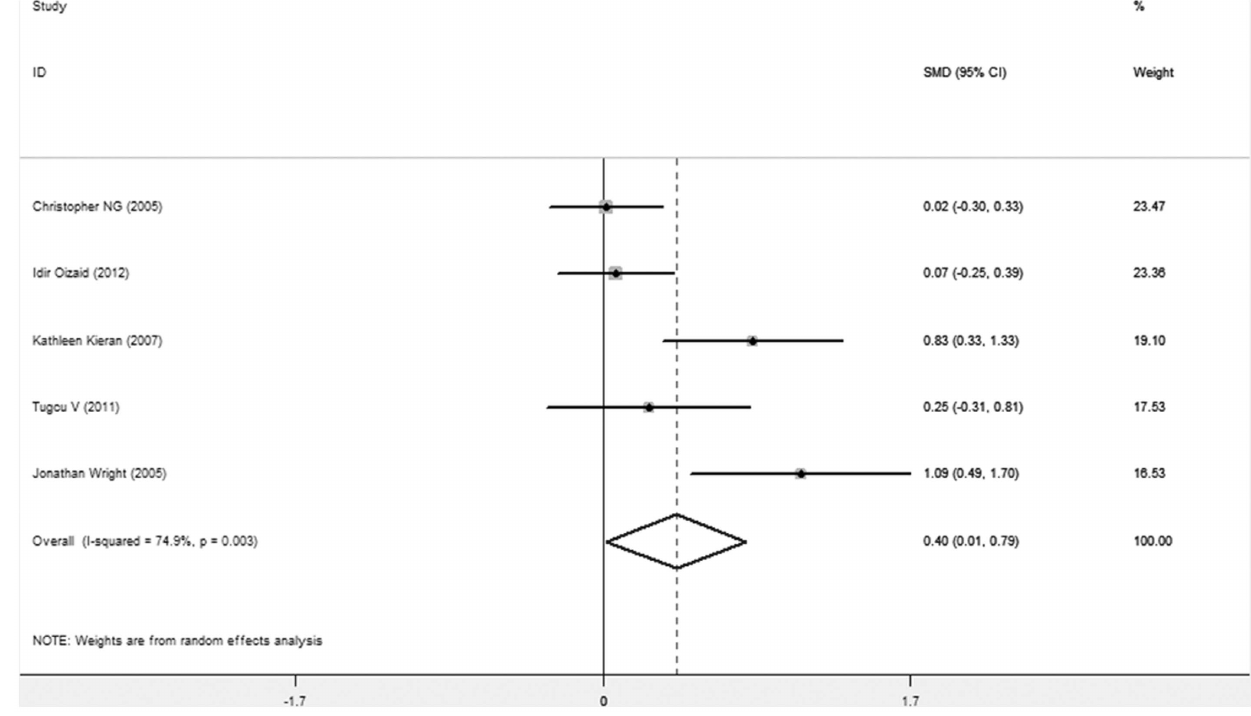
Figure 3. Forest plots of estimated blood loss TLPN vs RLPN using a random-effect model. Squares indicate study-specific risk estimates (size of the square reflects the study-specific statistical weight, i.e., the inverse of the variance); horizontal lines indicate 95% confidence intervals (CIs); diamonds indicate summary risk estimate with its corresponding 95% confidence interval.